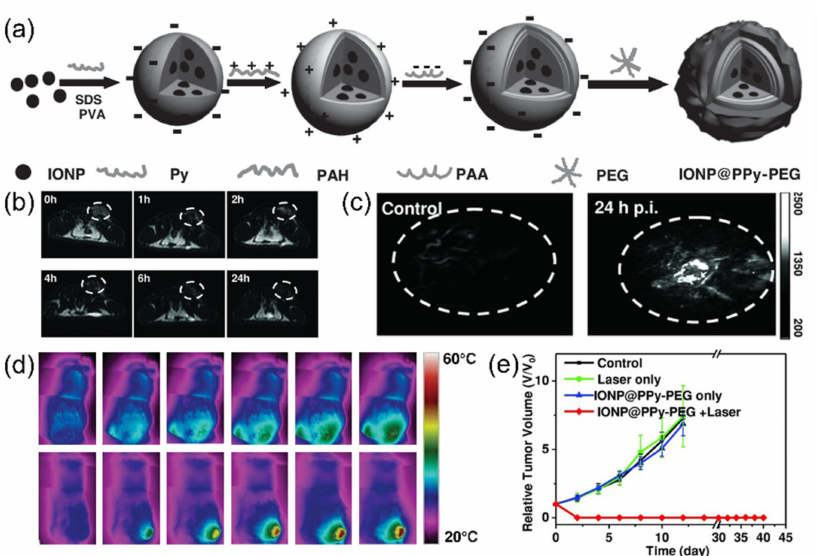
Figure 4. ( a ) Schematic illustration of the synthesis of IONP@PPy-PEG nanoparticles for 4T1 cancer treatment; ( b ) T2-weighted MR images of 4T1-bearing mice after intravenous injection of IONP@PPy- PEG (white circle: tumor sites); ( c ) photoacoustic images of tumor-bearing mice with IONP@PPy-PEG; ( d ) thermal images of mice with IONP@PPy-PEG after 808 nm laser irradiation; ( e ) growth curve of 4T1 tumors after treatment. Figures are reproduced from ref. [74] with permission from